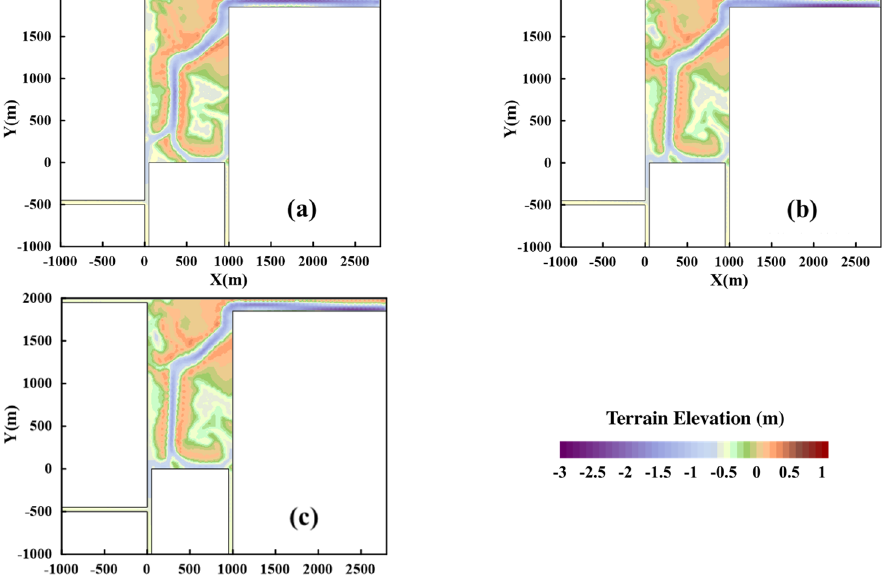
Figure 3. Terrain patterns of the ideal model of Qilihai Lagoon system after 100 years ( a ) without wind; ( b ) with wind shear stress on water surface; ( c ) with local wind-induced waves.